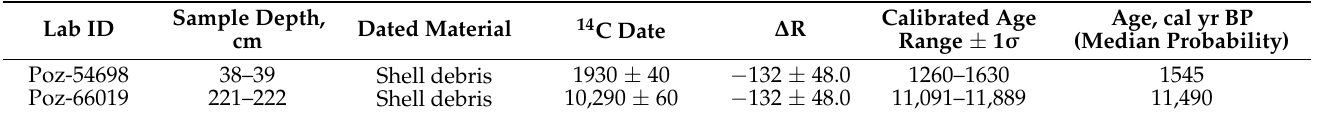
Table 1. Accelerator mass spectrometry (AMS) 14 C dates and calibrated ages from core PS-6066. Lab codes: Poz—Pozna´n Radiocarbon